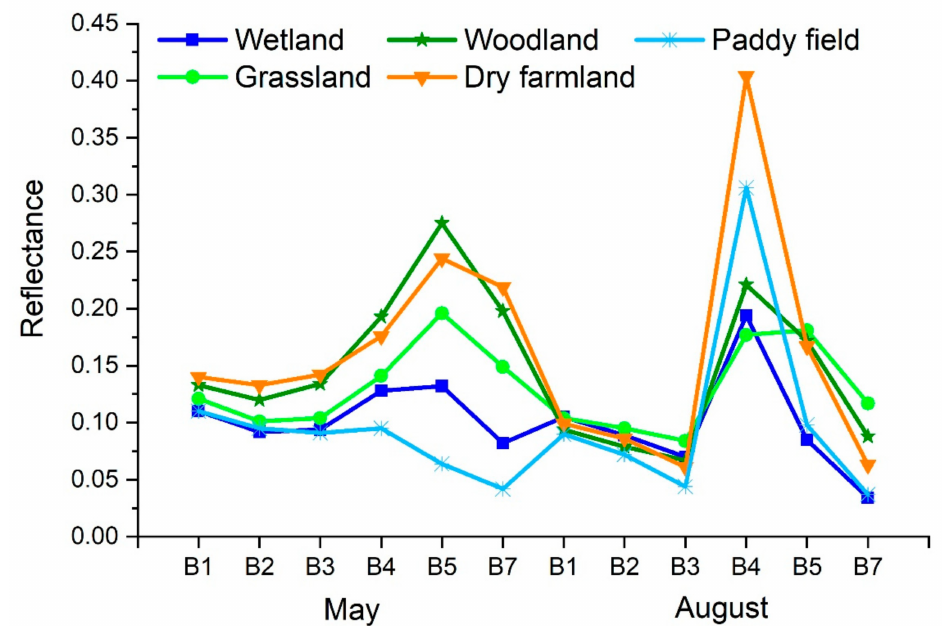
Figure 4. Mean reflectance spectra of wetland and other land